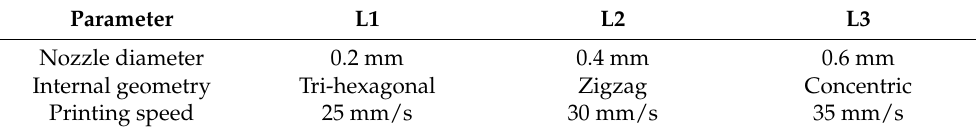
Table 2. Selected independent variables for fatigue tests.